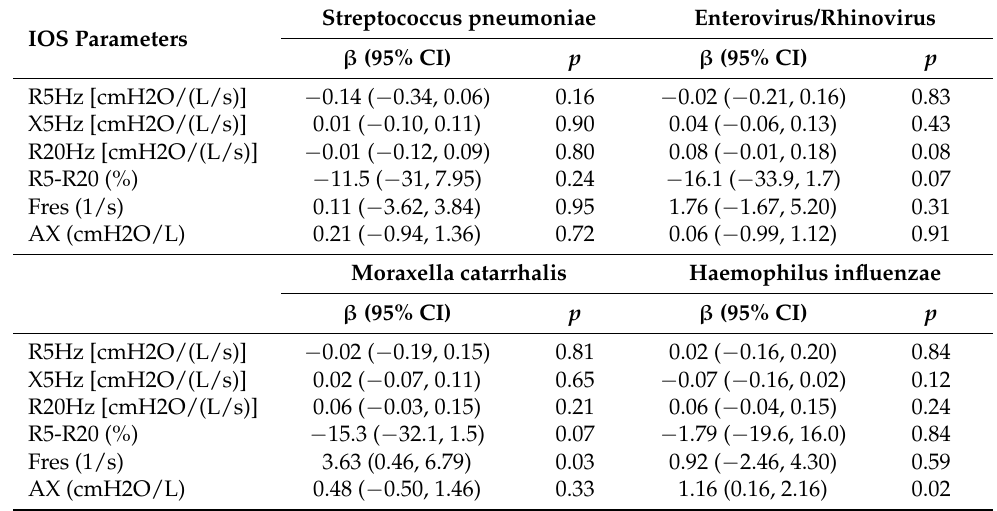
Table 4. Associations between specific nasopharyngeal pathogens and impulse oscillometry (IOS)